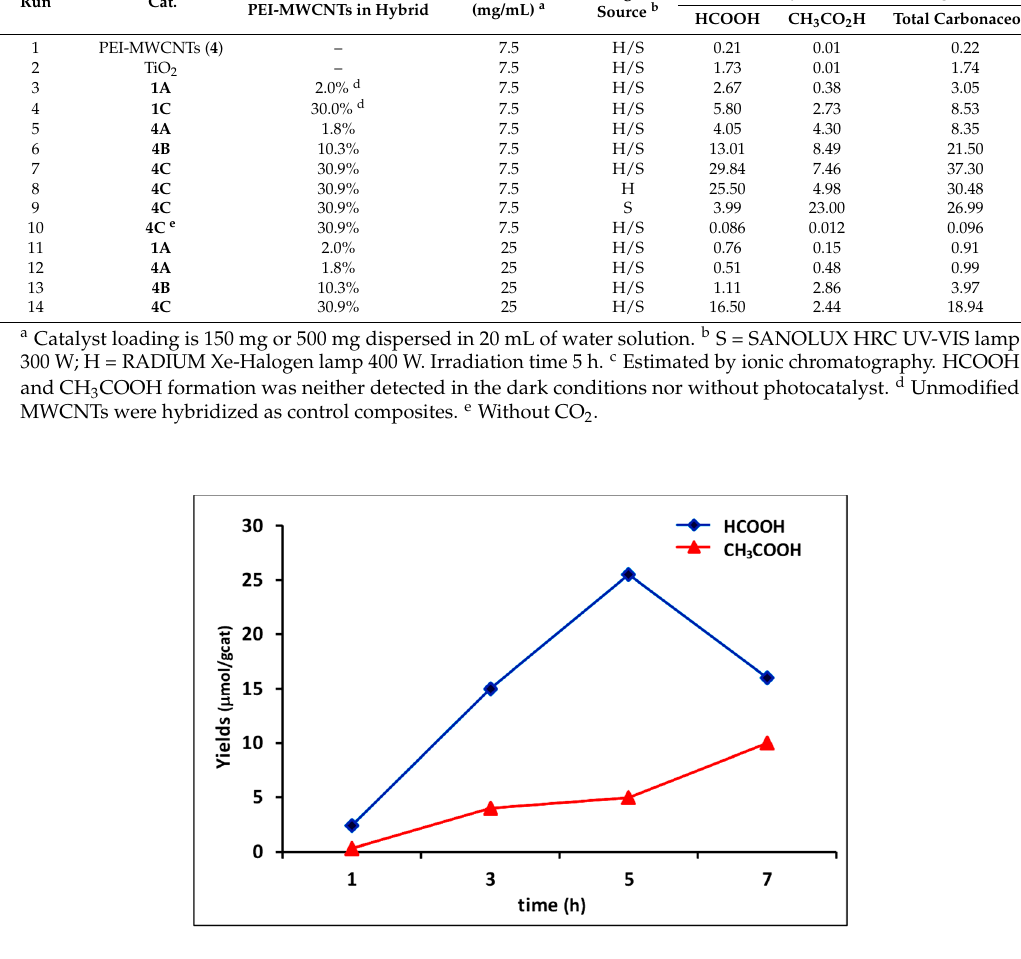
Figure 6. Monitoring of yields versus time in photocatalysis with composite 4C (experimental conditions of run 7, Table 5).